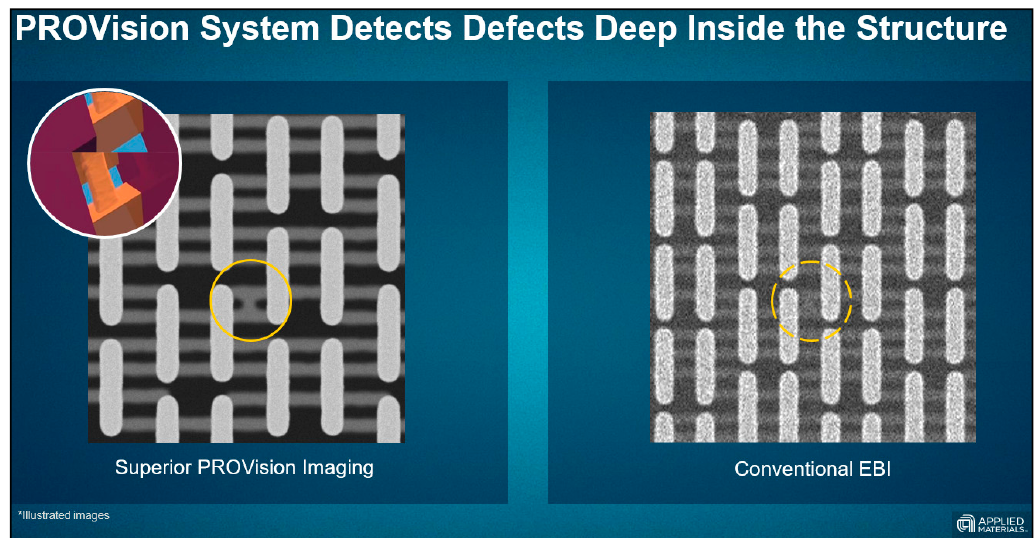
Figure 23. Applied Materials PROVision e-beam’s capability.